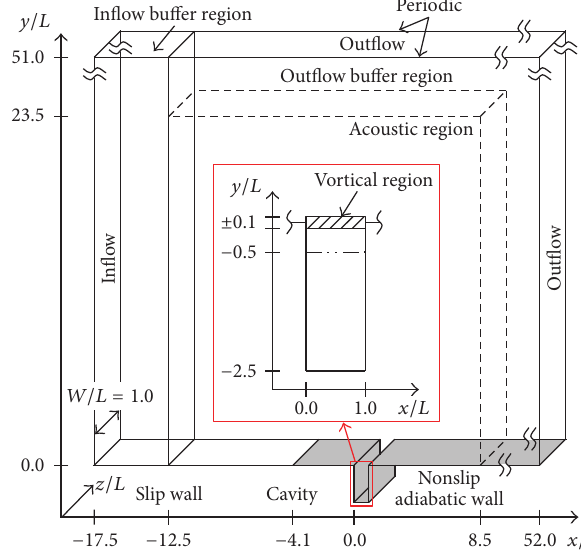
Figure 4: Computational domain and boundary conditions.